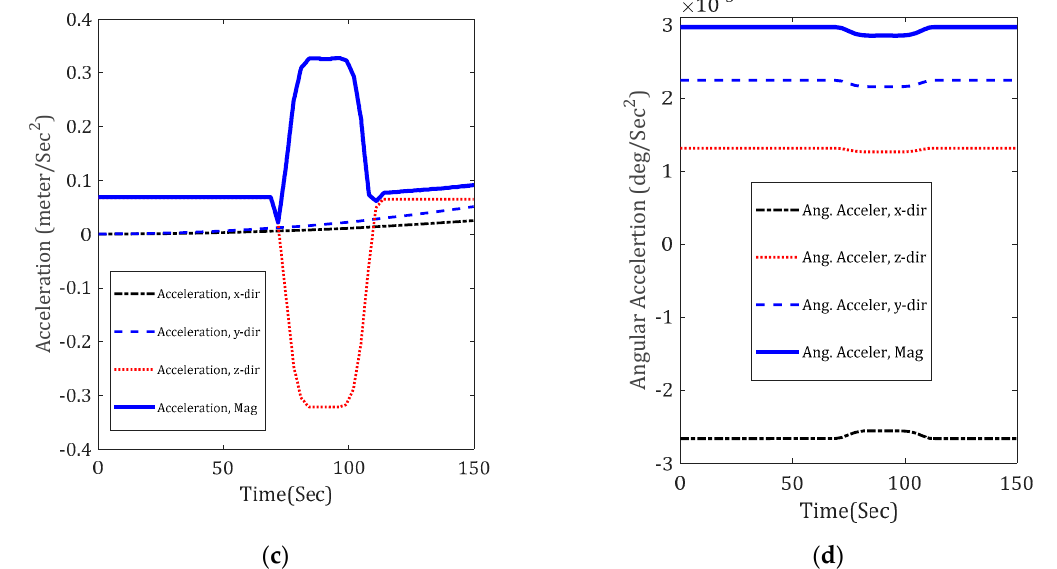
Figure 9. ( a ) Variations in linear velocities, ( b ) angular velocities, ( c ) linear accelerations, and ( d ) angular accelerations of the JQ in the compatibility scenario.